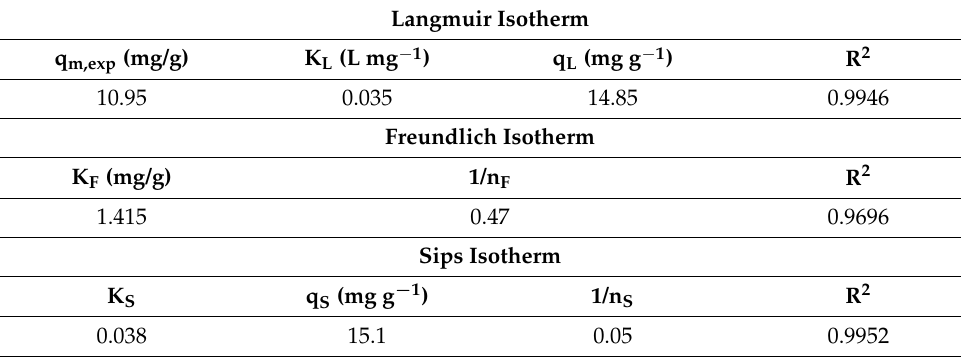
Table 6. Isotherm parameters obtained based on adsorption isotherm. Langmuir Isotherm